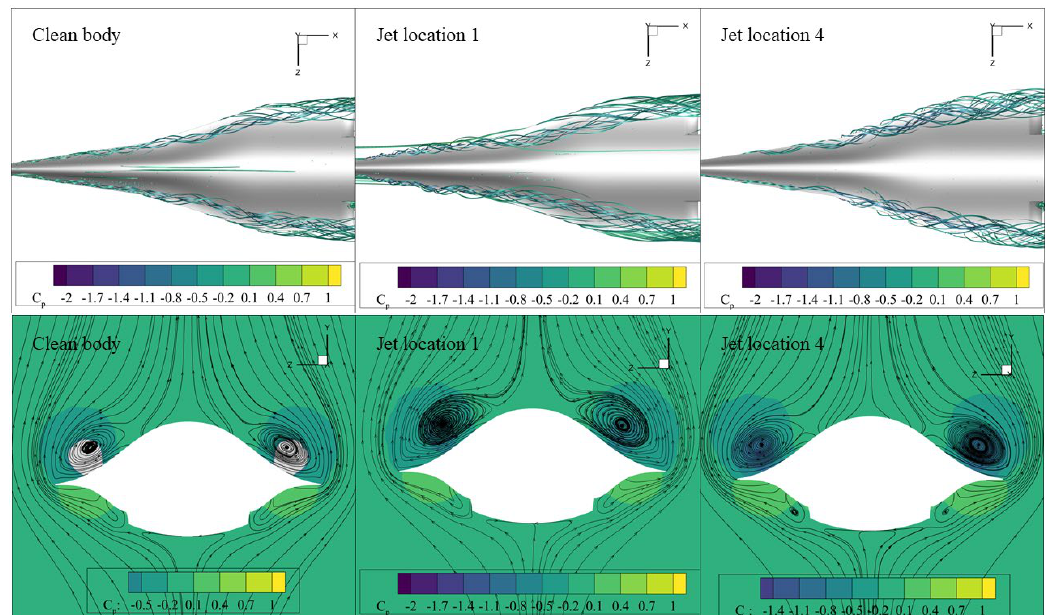
Figure 13. Comparison of the streamlines for different blowing directions at α = 10 ◦ , x / L 0 =